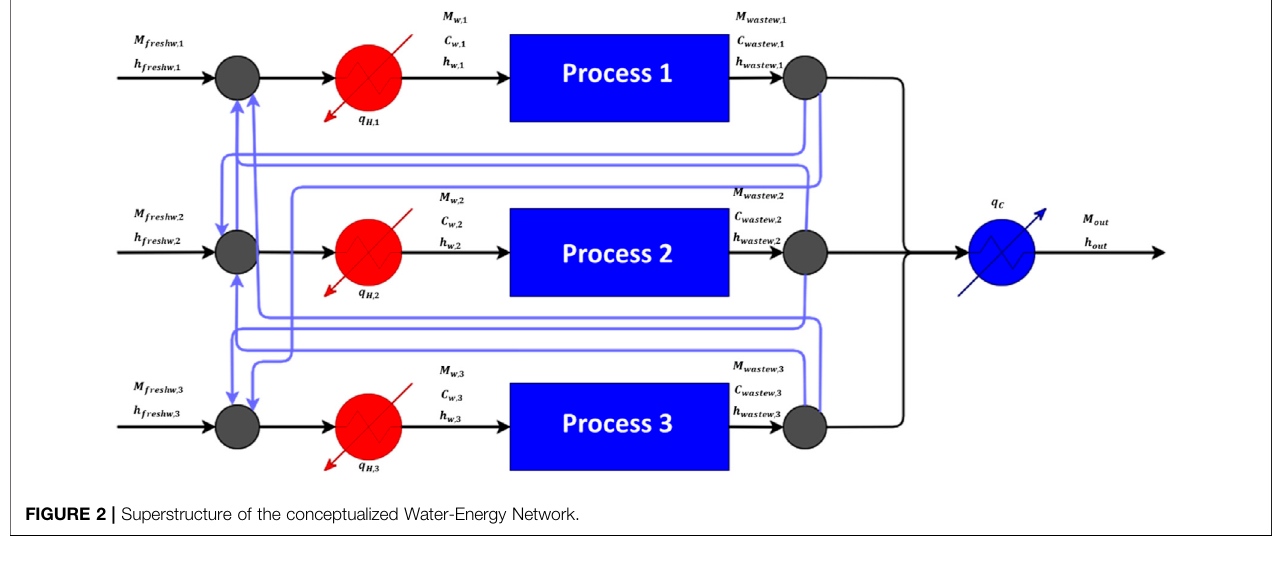
FIGURE 2 | Superstructure of the conceptualized Water-Energy Network.